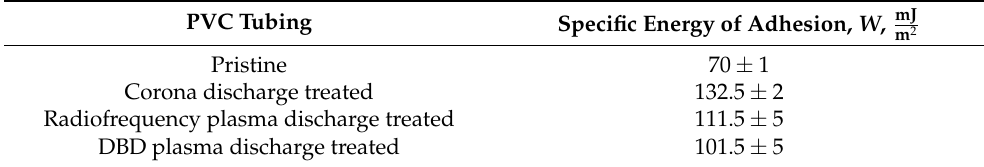
Table 1. Specific energy of adhesion established with the Dupre formula for the pristine and plasma-treated PVC tubing.